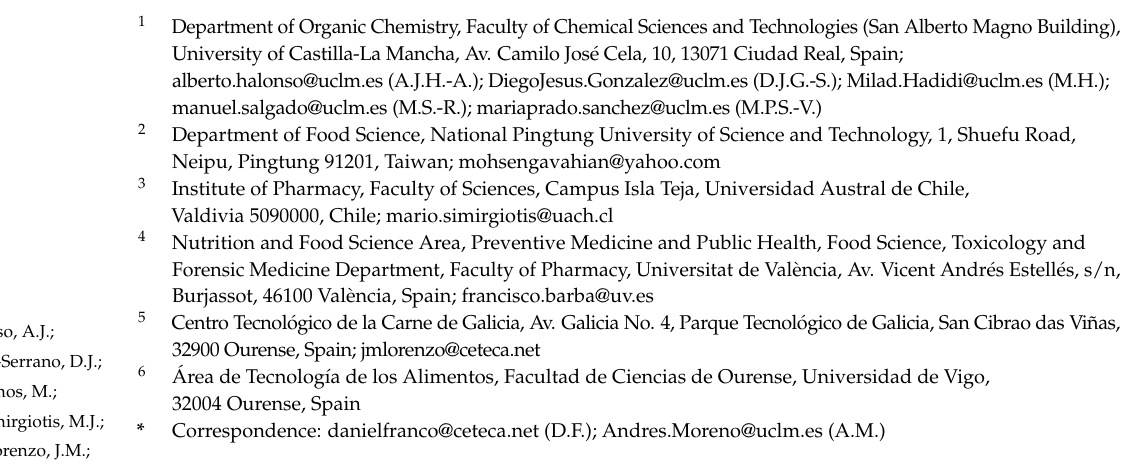
Table Olives: NMR Identification of Antioxidant Phenolic Fraction and Microwave Single-Phase Reaction